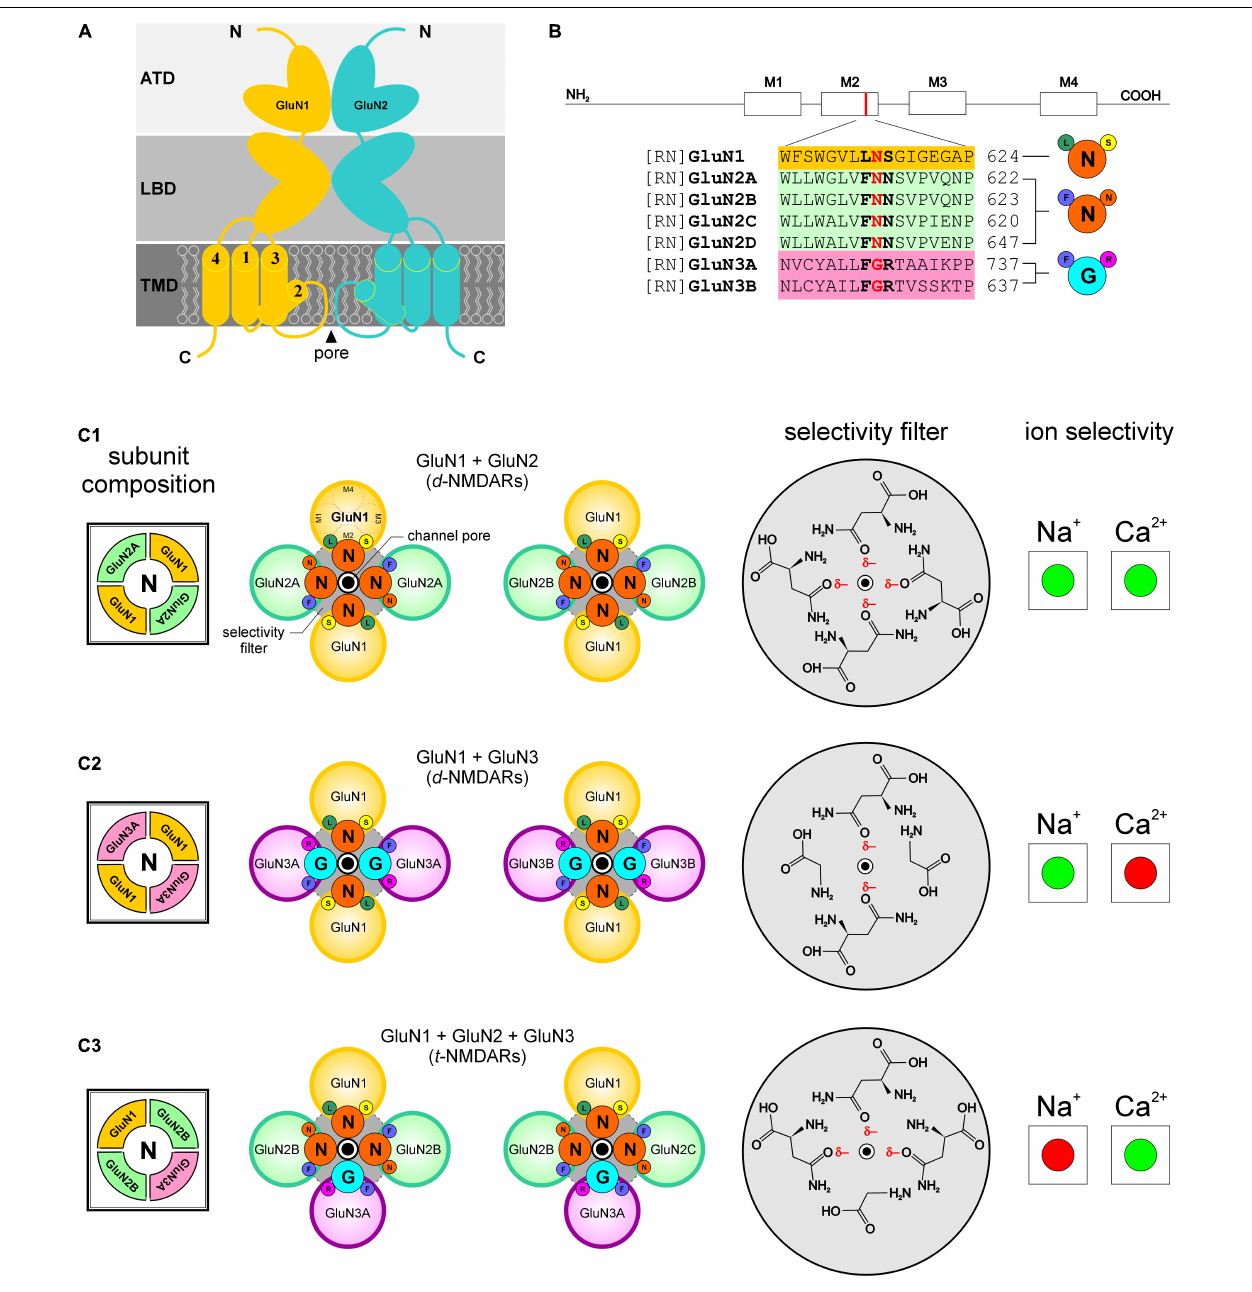
FIGURE 2 | Selectivity for and permeability to cations in NMDARs is dependent on the combination of receptor subunits and ultimately on the sequence of amino acids that compose the selectivity filters in the pore-forming region of the receptor channels. Portions of this figure are taken from Beesley et al. (2019) to showcase differences in the selectivity filters of the identified receptors. (A) NMDAR schematic identifying various domains within subunits (ATD amino terminal domain, LBD ligand binding domain, TMD transmembrane domain; N, amino and C, carboxyl terminals) and the M2 helix which contributes to the pore-forming region of the receptor channel. (B) Predicted segments of the TMD and M2 sequence alignment of GluN1; GluN2A, 2B, 2C, 2D; GluN 3A, 3B from rat (RN, rattus norvegicus ). Amino acid residues determining functional channel properties are indicated in bold and conserved residues determining ion selectivity in red. Numbers refer to amino acid positions within subunits. Abbreviations for the amino acid residues are: A, Ala; C, Cys; E, Glu; F, Phe; G, Gly; I, Ile; K, Lys; L, Leu; N, Asn; P, Pro; Q, Gln; R, Arg; S, Ser; T, Thr; V, Val; W, Trp; and Y, Tyr. (C1–C3) Schematic arrangement of subunits and amino acid residues that constitute the putative selectivity filters in the identified NMDARs (N, left ), and their selectivity (enhanced, green; diminished, red) for Na + and/or Ca 2 + ions ( right ). Notice how the ring of partial negativity, arising from arrangement of partial negative charges ( δ –) on asparagine’s polar side chains (C1–C3) , in the selectivity filter for GluN1 and GluN2-containing d- NMDARs ( gray circle , top panel, C 1 ; ring charge, r q = –4) is altered following changes in receptor subunit composition (middle panel, C2 ; r q = –2 and bottom panel, C 3 ; r q = – 3). The polar amino acids within the selectivity filters are depicted schematically such that they adopt energetically favorable orientations enabling their hydrophilic side chains to interact with the outside environment (i.e., the channel pore).